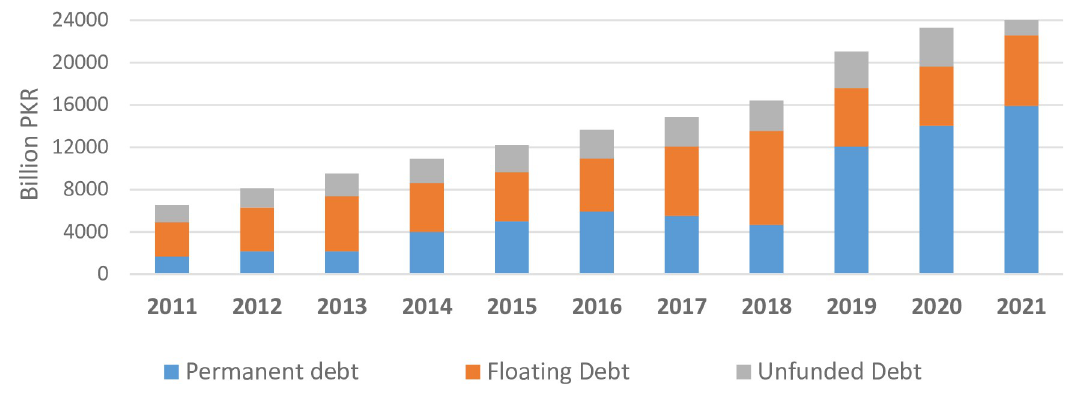
Fig 3. Domestic debt composition.